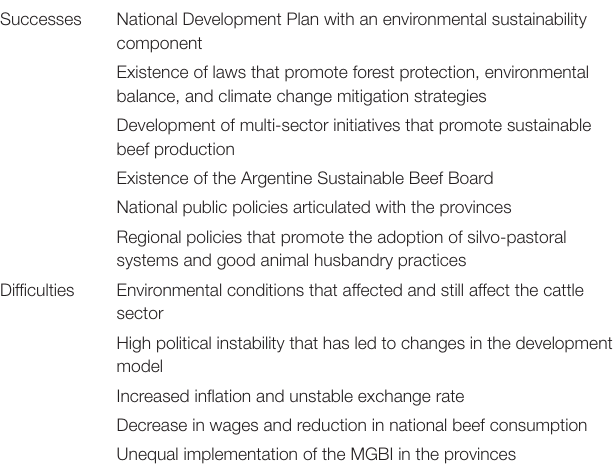
TABLE 4 | Successes and difficulties in the implementation of public policies in Argentina.